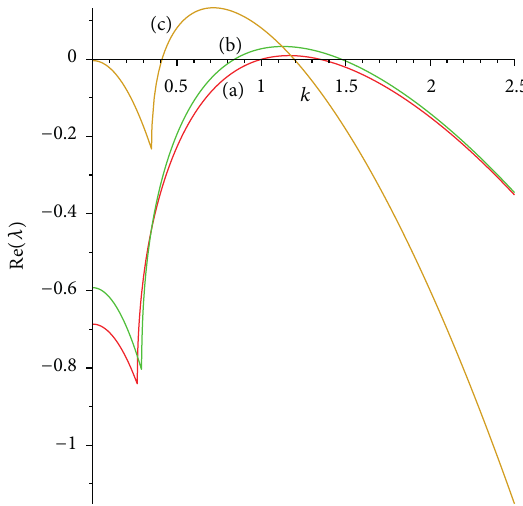
Figure 1: An illustration of the dispersion relation from (21). We set the parameter values such that (a) 𝛾 = 1 , 𝑑 = 0.08 , 𝑠 = 1.55 , 𝜏 = 0.1 , = 0.1 , and 𝐷 = 3.68 ; (b) 𝛾 = 1 , 𝑑 = 0.08 , 𝑠 = 1.31 , 𝜏 = 0.2 , 𝐷 𝑢 V = 0.1 , and 𝐷 = 3.68 ; (c) 𝛾 = 1 , 𝑑 = 0.05 , 𝑠 = 0.5 , 𝜏 = 0.3 , 𝐷 𝑢 V = 0.25 , and 𝐷 = 3 𝐷 𝑢 V